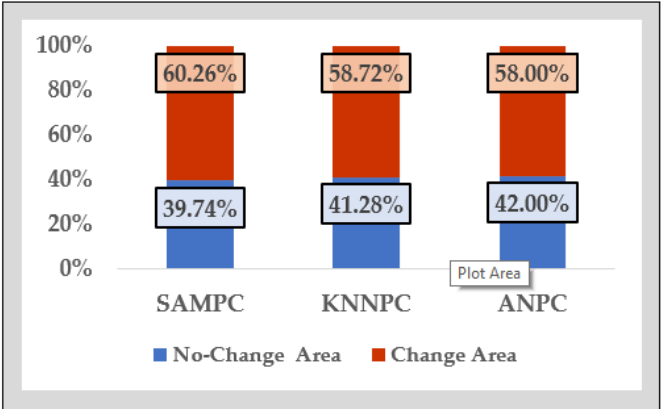
Figure 6. Graphical representation of “change/no-change” area computed from different change detection methods, i.e., SAMPC, SVMPC, and ANNPC, using Hyperion EO-1.